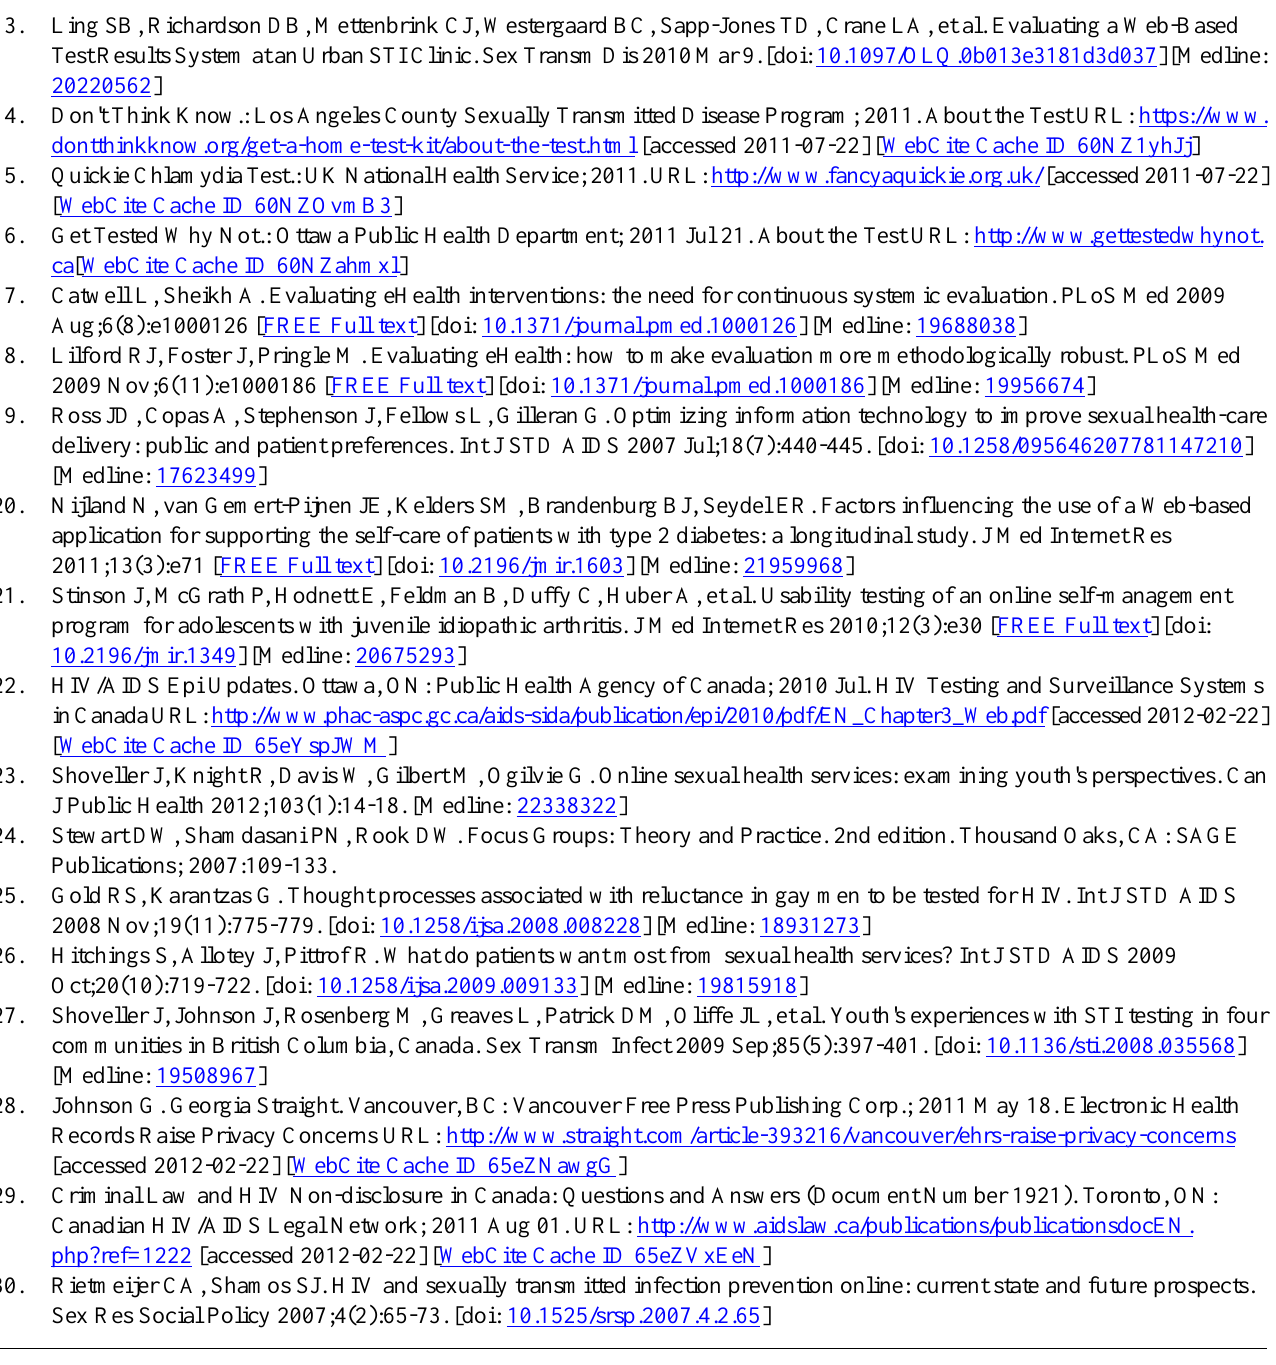
Abbreviations BCCDC: British Columbia Centre for Disease Control HIV: human immunodeficiency virus MSM: men who have sex with men STI: sexually transmitted